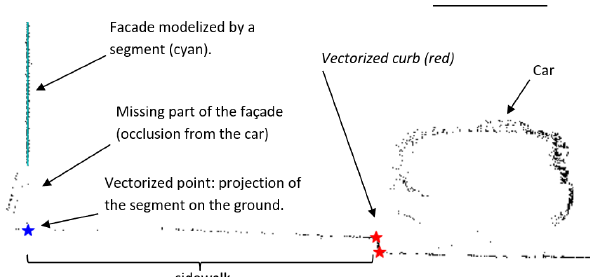
Figure 5: Facade vectorization with missing parts.